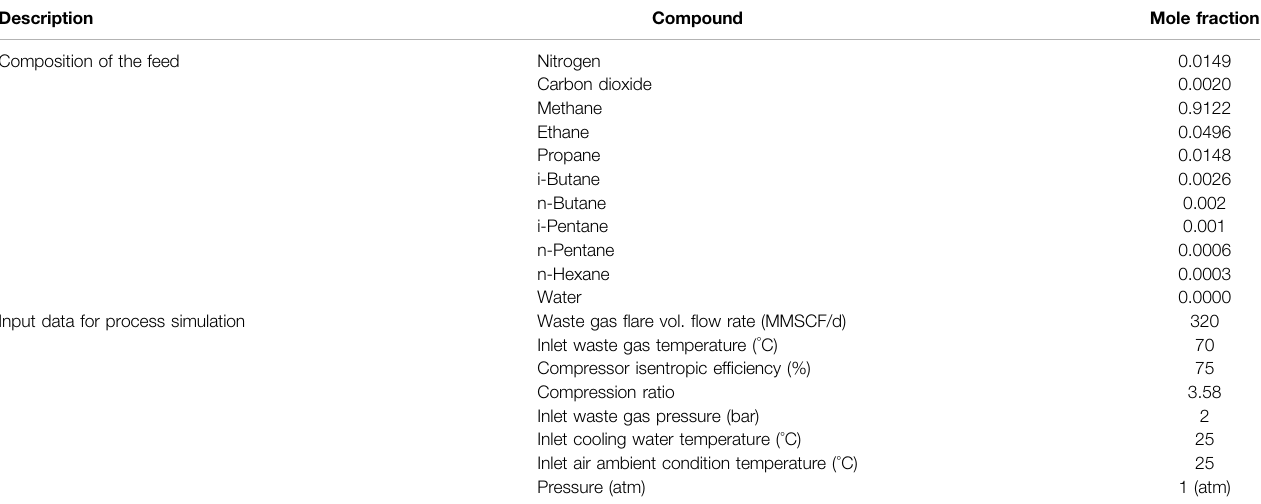
TABLE 1 | Composition of the feed.